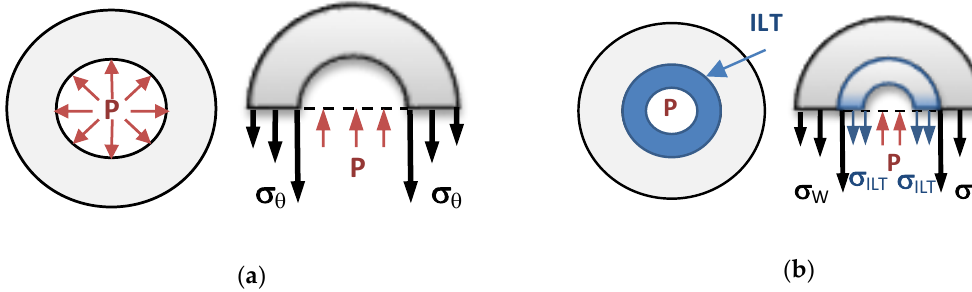
Figure 2. Sketch of stresses acting on a perfectly cylindrical blood vessel. ( a ) Cylindrical vessel wall (gray) subjected to an internal blood pressure ( P ). If we cut the cylinder in half as shown in the right sketch, then equilibrium of forces requires that the pressure is equilibrated to the circumferential wall stress ( σ θ ), as seen in Equation (1). ( b ) Cylindrical vessel wall (gray) with intraluminal thrombus (ILT, depicted in blue). The pressure force is equilibrated by both circumferential wall stresses in the wall ( σ W ) and the ILT ( σ ILT ), thus lowering the wall stress.